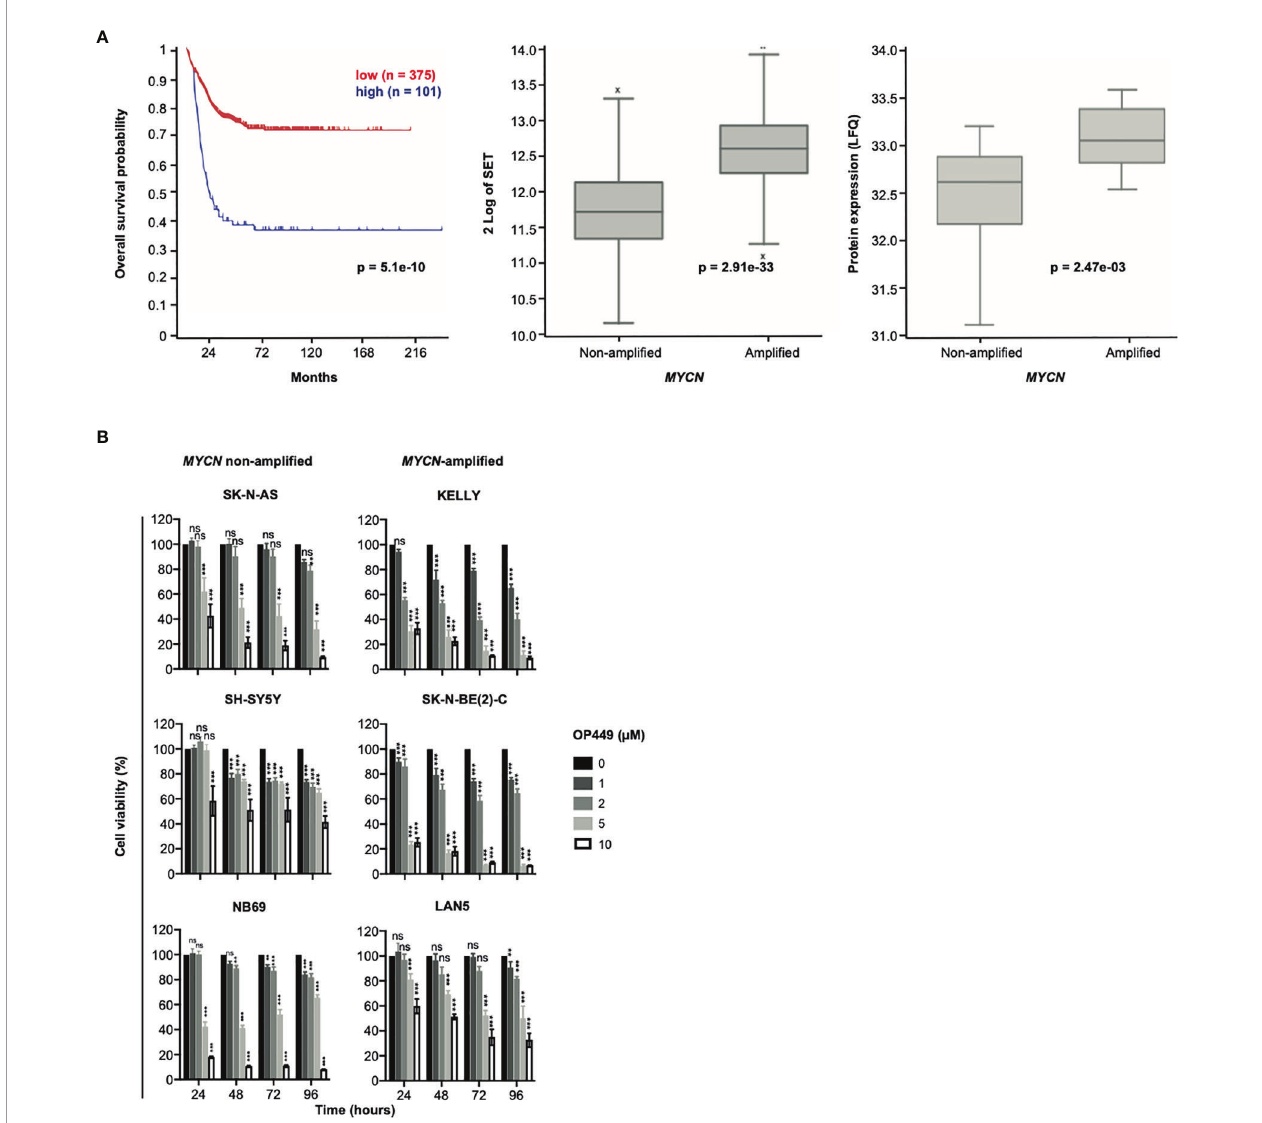
FIGURE 3 | SET is overexpressed in poor-prognosis neuroblastoma (NB), and the SET inhibitor OP449 inhibits NB cells. (A) SET overexpression in poor-prognosis NB. Overall Kaplan – Meier survival estimates of 649 NB patients (gse45545) depending on SET transcript levels, as determined by microarray analysis and dichotomized by maximally selected log-rank statistics, are shown in the left panel. SET mRNA expression in MYCN -ampli fi ed and non-ampli fi ed tumors of the same patient cohort is depicted in the middle panel and SET protein expression of a different patient cohort (38) in the right panel. (B) OP449 decreases viability of NB cells. NB cell lines were treated with OP449 at increasing doses and duration. Cell viability was determined by MTT assay and normalized to untreated controls. Experiments were repeated three times. Data are expressed as means ± SEM of triplicates and analyzed by two-way ANOVA test. *p < 0.05, **p < 0.01, ***p < 0.001; ns, not signi fi